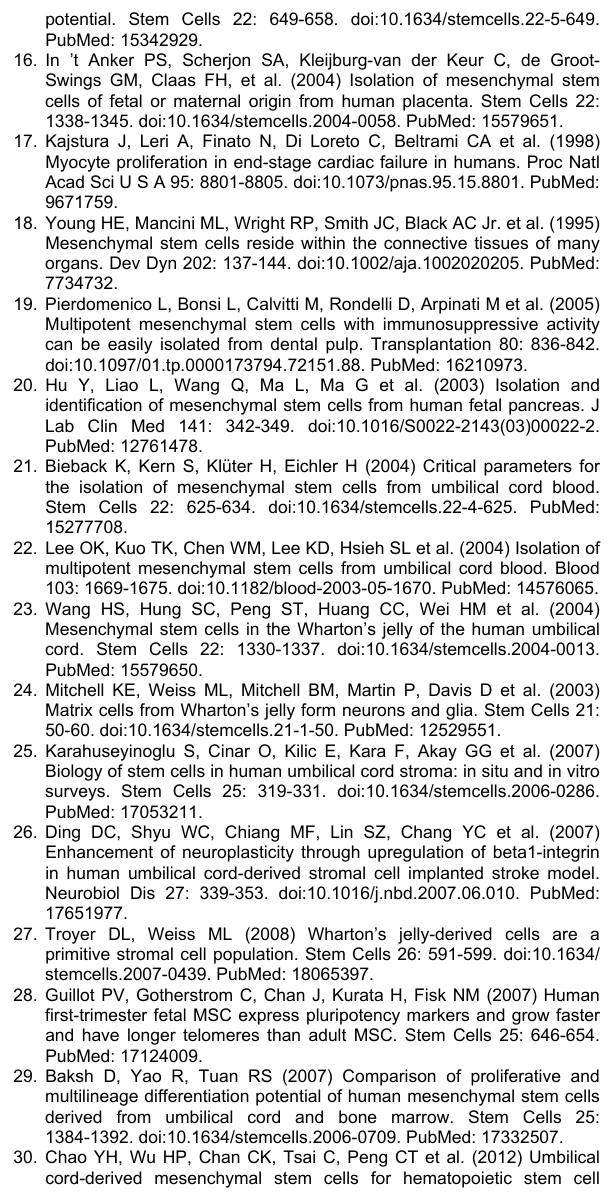
Figure S4. No tumorigenicity in mUC-MSCs. Nude mice were administered 1 × 10 6 cells of mUC-MSCs (red arrow) or colon-cancer cell line (blue arrow) for 2 months by subcutaneous injection. No tumor formation was observed in the mUC-MSCs treated side of the mouse.